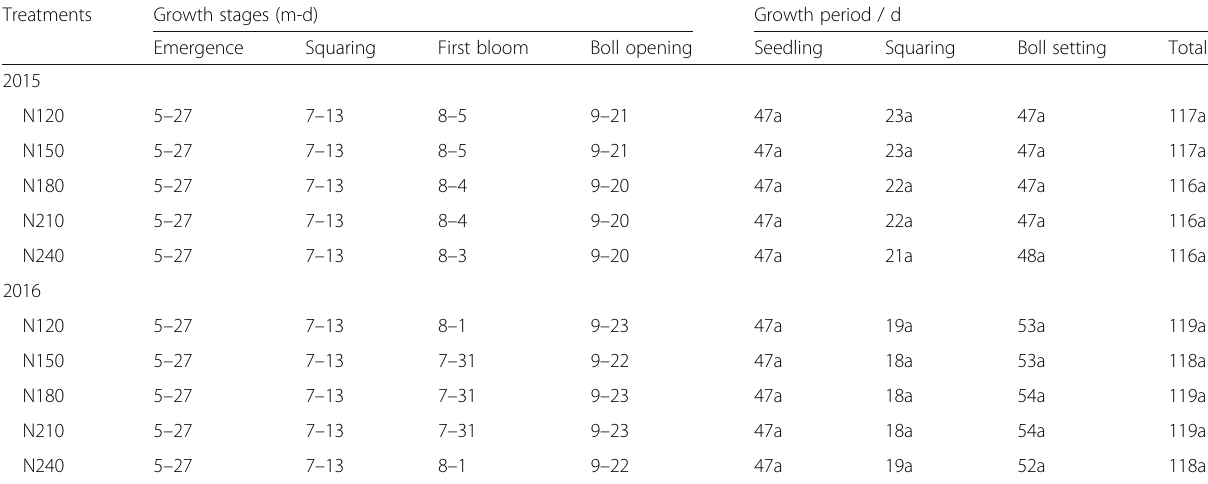
Table 1 Cotton growth stage and period under different N rate in 2015 and 2016